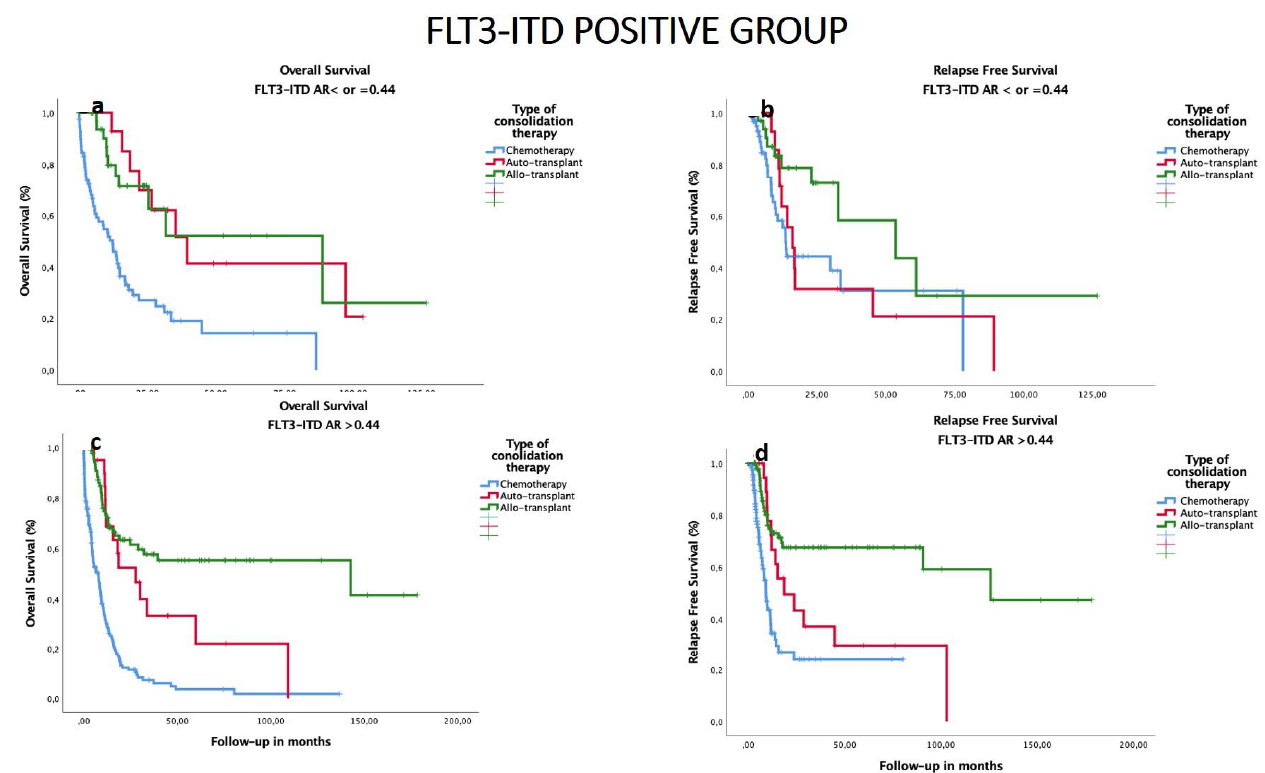
Figure 4. Impact of consolidation on OS and RFS in the groups with ratio of FLT3–ITD ≤ 0.44 vs. ratio > 0.44 in cohort of patients with FLT3–ITD-mutated AML. ( a ) The estimated OS median in group with FLT3–ITD AR ≤ 0.44 was 7.8 for chemotherapy, 39.4 for auto-HSCT ( n = 15, 7 censored events), and 88.8 months for allo-HSCT ( n = 34, 11 censored events) ( p = 0.88 comparing auto- vs. allo-HSCT). ( b ) The estimated median RFS in group with FLT3–ITD AR ≤ 0.44 was 9.2 for chemotherapy, 18.7 for auto-HSCT, and 56.7 for allo-HSCT ( p = 0.01). ( c ) The estimated median OS in group with FLT3–ITD AR > 0.44 was 12.3 months for chemotherapy as consolidation therapy, 27.8 for auto-HSCT ( n = 21, 7 censored), and 59.9 for allo-HSCT ( n = 96, 62 censored) ( p = 0.09 comparing auto- vs. allo-HSCT). ( d ) The estimated median RFS in group with FLT3–ITD AR > 0.44 was 13.6 for chemotherapy, 16.1 for auto-HSCT, and 53.5 (6.1 – 100.9) for allo-HSCT ( p = 0.01).